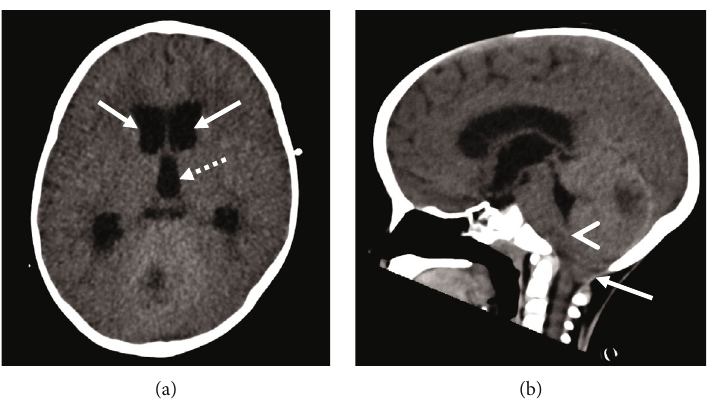
Figure 4: Noncontrast head CT images from hospital day 3 associated with neurological decline. (a) Axial CT image shows enlargement of the lateral (arrows) and third (dashed arrow) ventricles, and (b) midline sagittal CT image shows cerebellar swelling, e ff acement of the inferior fourth ventricle (arrowhead), and cerebellar tonsillar herniation (arrow).